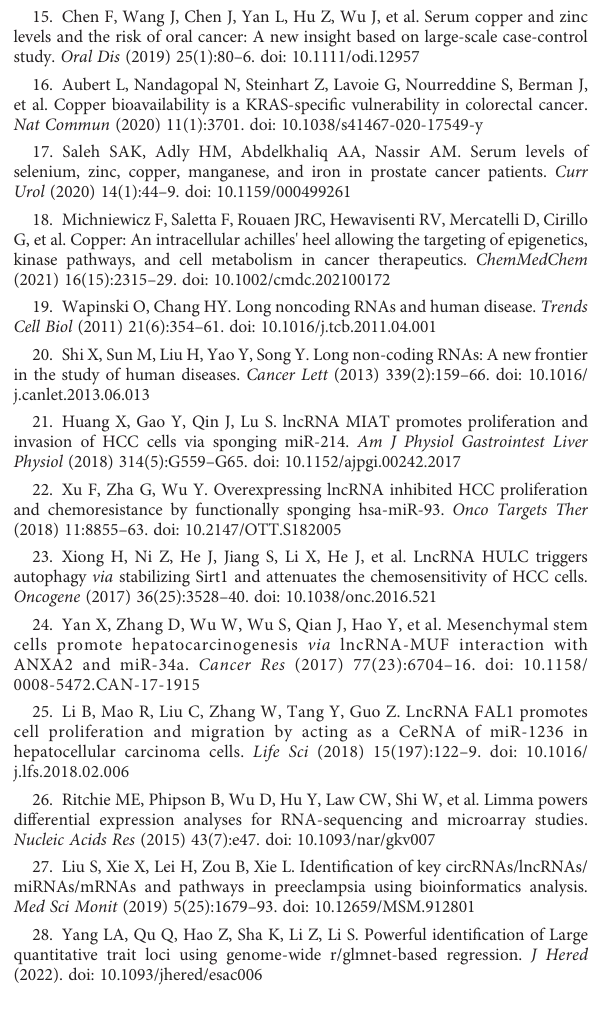
SUPPLEMENTARY TABLE 2 Screening of genes with different risks of